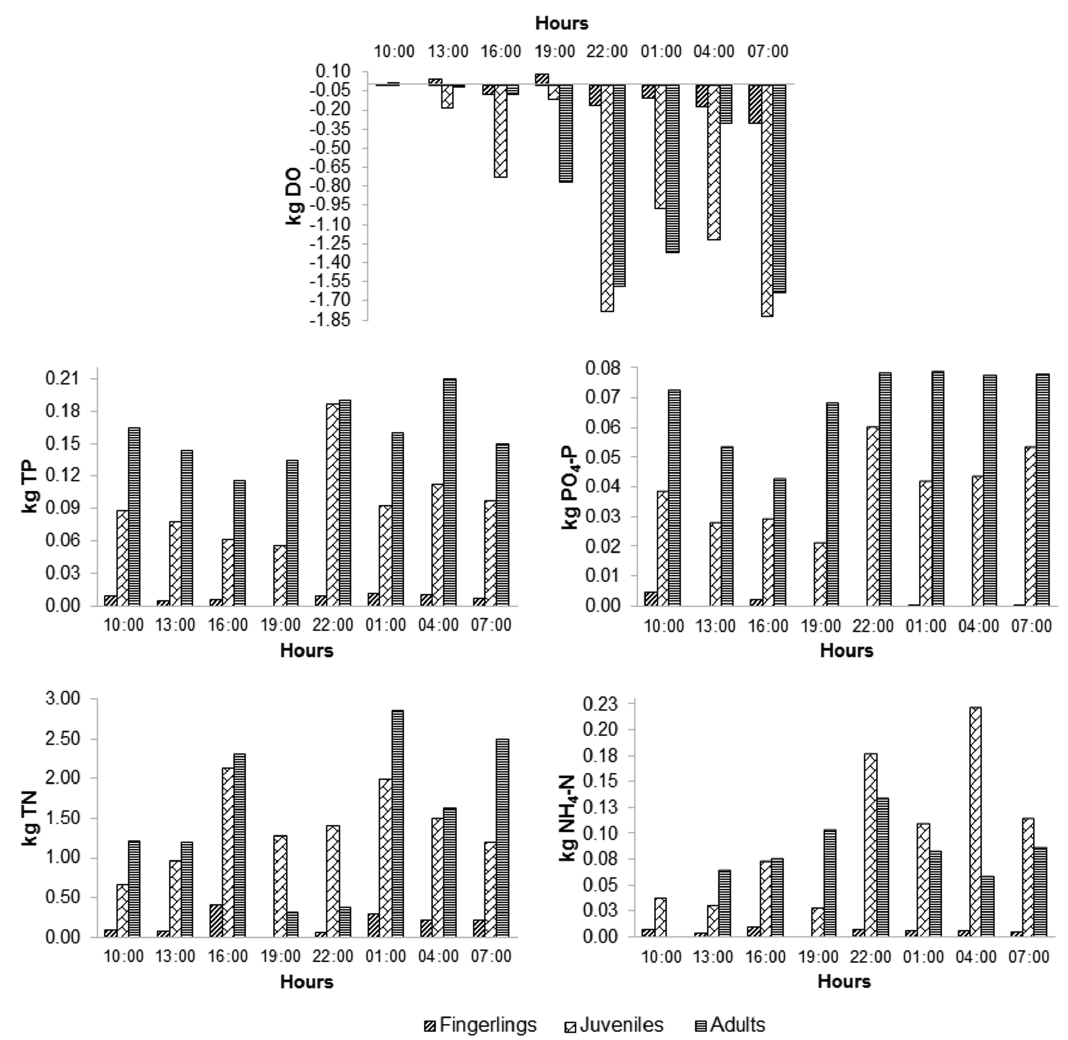
Figure 4. Daily mass balance (kg) of dissolved oxygen (DO), total phosphorus (TP), orthophosphate (PO nitrogen (TN) and ammonium (NH